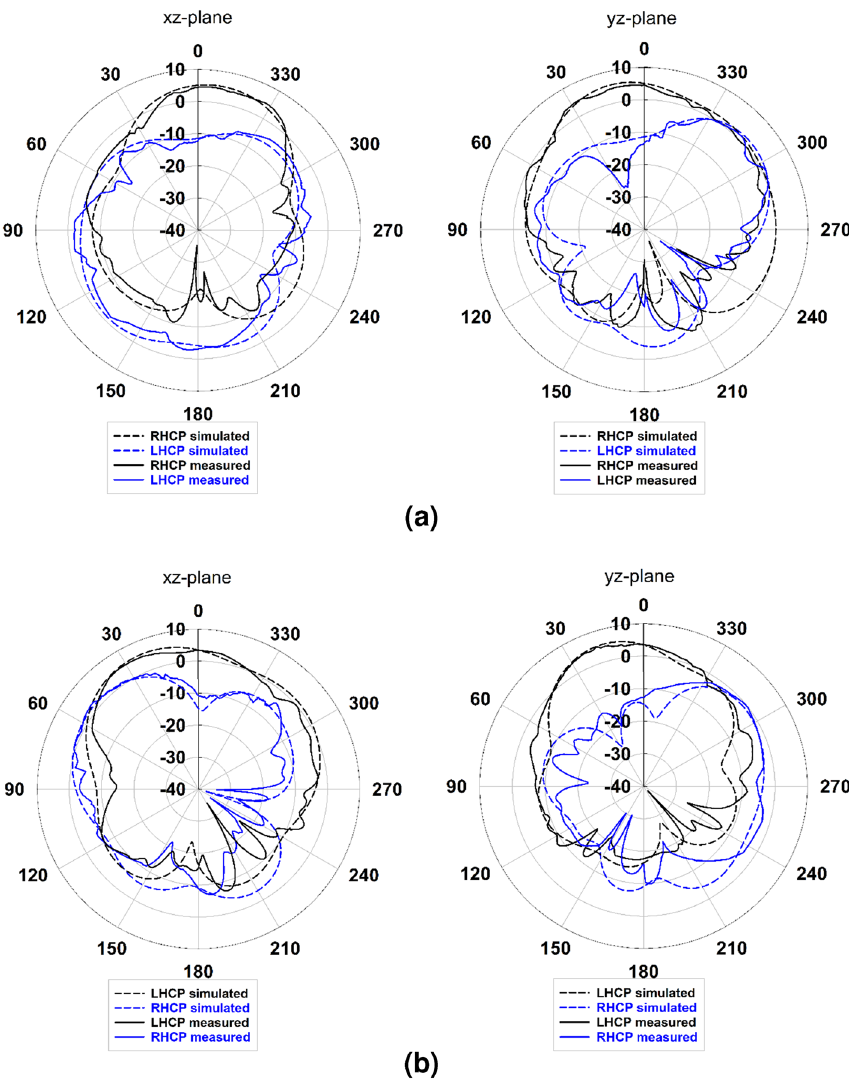
Figure 12. Simulated and measured RHCP and LHCP radiation patterns of the proposed antenna in xz -plane (left) and yz -plane (right) at 5.9 GHz; ( a ) Port 1 and ( b ) Port 2.